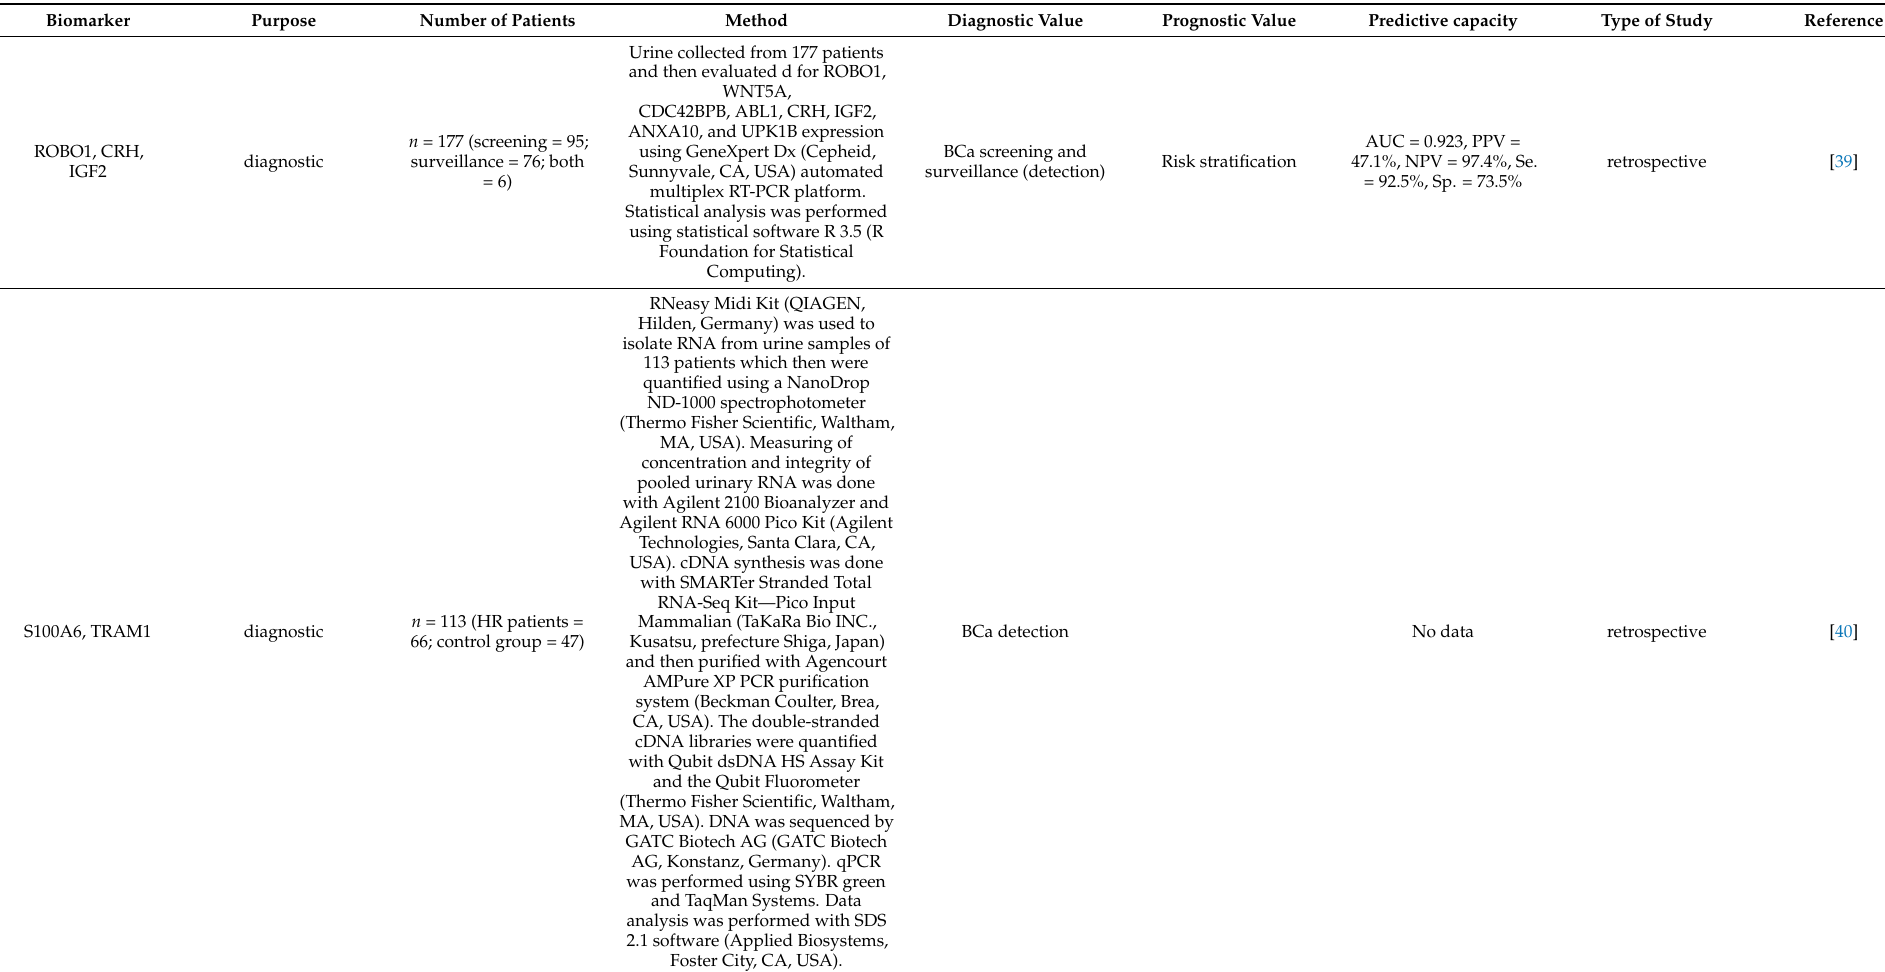
Table 4. Table presenting data for mRNA